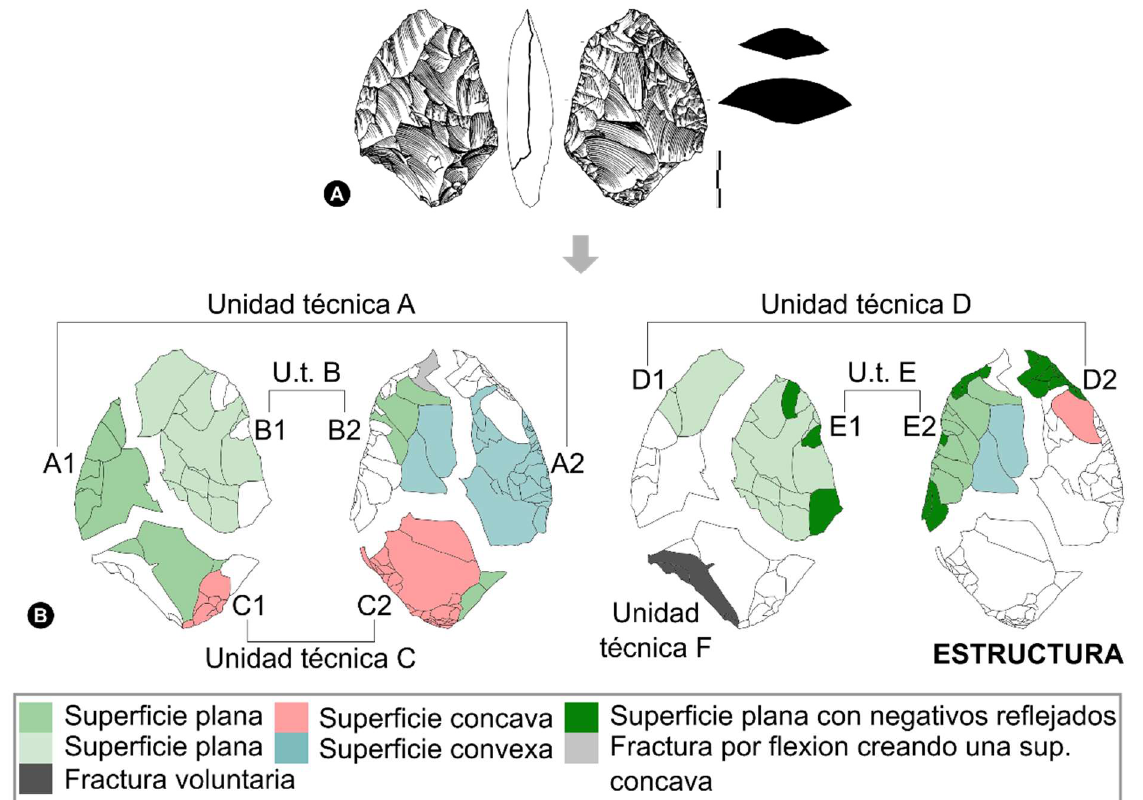
Figura 9. Ejemplo de análisis técnico-funcional de una pieza bifacial procedente de la capa C’3base del sitio de Barbas I, Dordoña (Boëda 2001: 63, figs 8 y 9): (A) dibujo de la pieza, (B) determinación de unidades técnico- funcionales que definen la estructura tripartita de la pieza bifacial. Posteriormente, a nivel interpretativo,